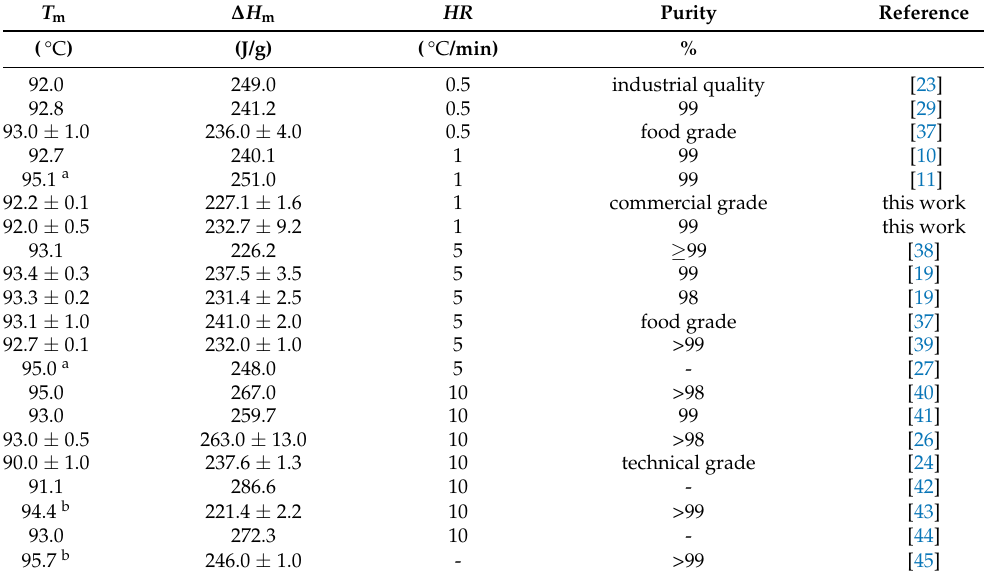
Table 2. Melting temperature (onset), T m , and latent heat of melting, ∆ H m , of xylitol measured by DSC at different heating rates ( HR